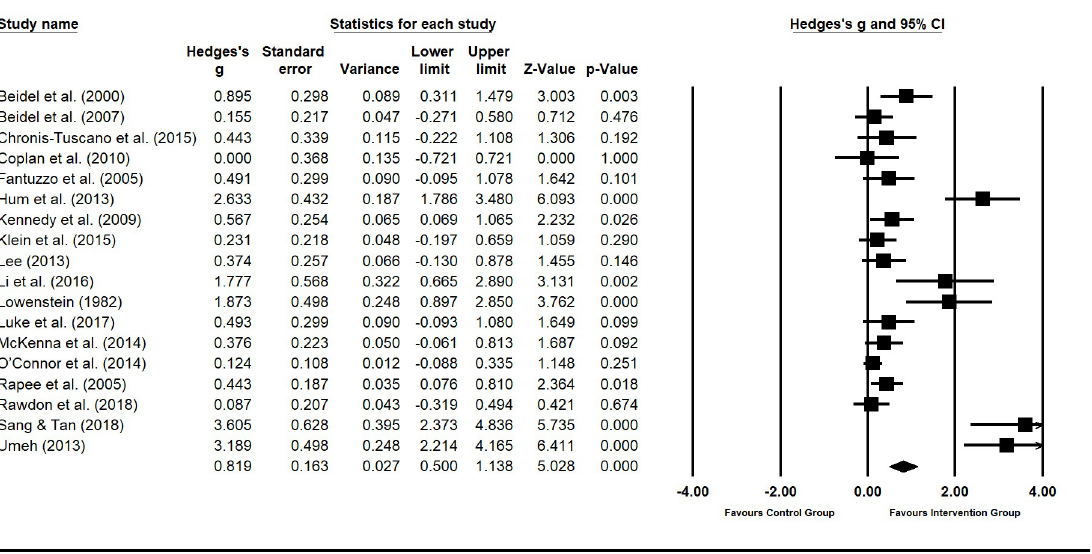
Focus . Interventions focusing on both children and their parents demonstrated a large but non-significant effect size when compared to control groups ( z (3) = 1.54, Hedge’s g = 1.01, p =